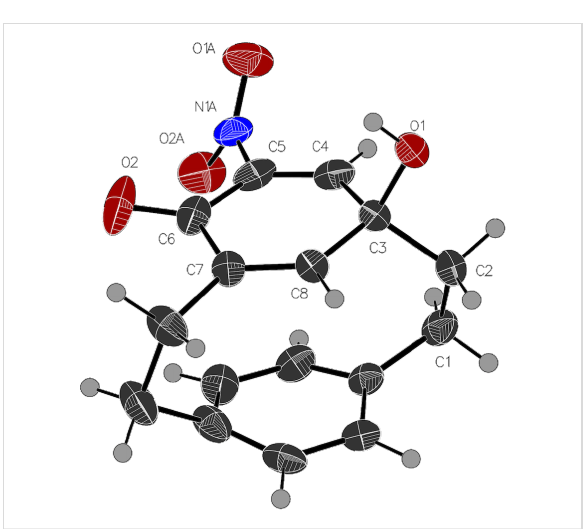
Figure 3: Crystal structure of 6 . Ellipsoids are drawn at a 50% proba- bility level [63].